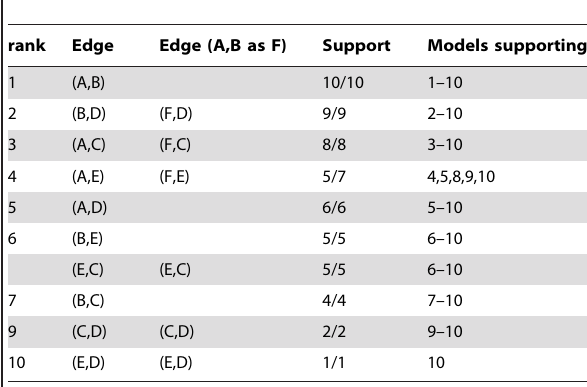
Table 1. Ranking of the strength of dependency of each pair of editing sites in human 5-HT 2C R